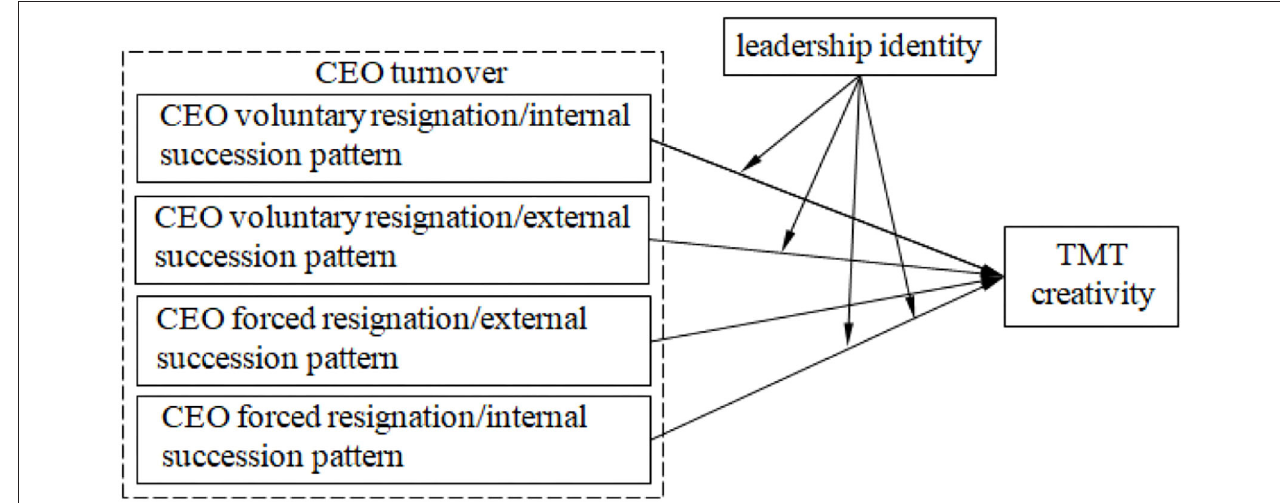
FIGURE 2 | The theoretical